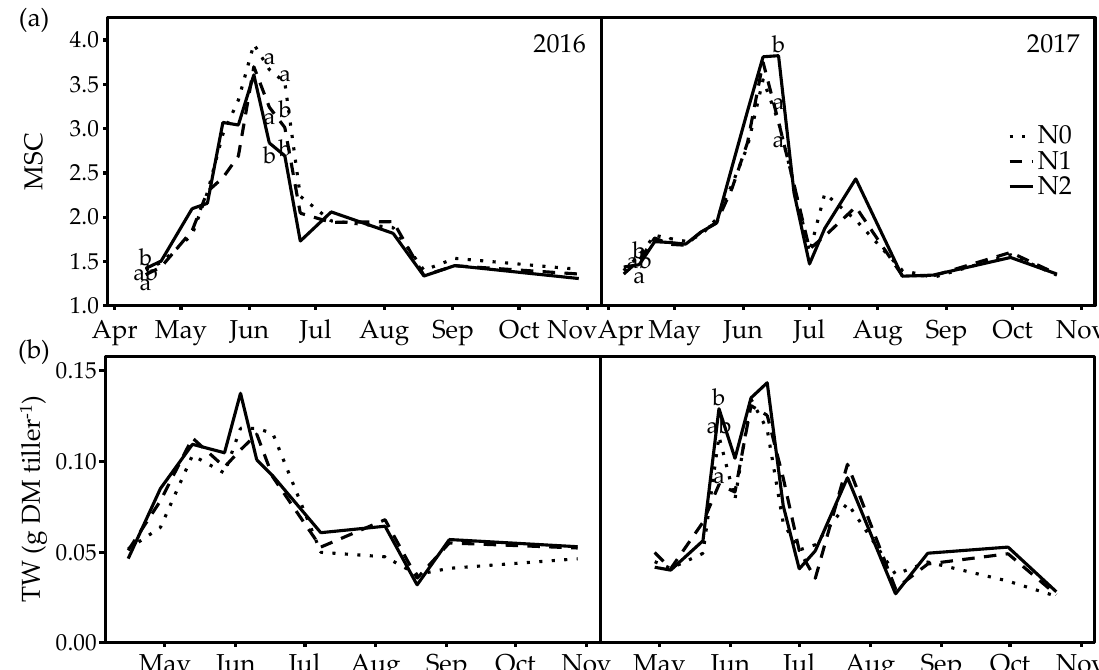
Figure 3. ( a ) Mean stage by count (MSC) and ( b ) tiller weight (TW) during the vegetation periods of 2016 and 2017 for three N application rates (0 (N0), 140 (N1) and 280 (N2) kg N ha − 1 ). Mean values at the same date with different superscripts differ between N application rates ( p ≤ 0.05).